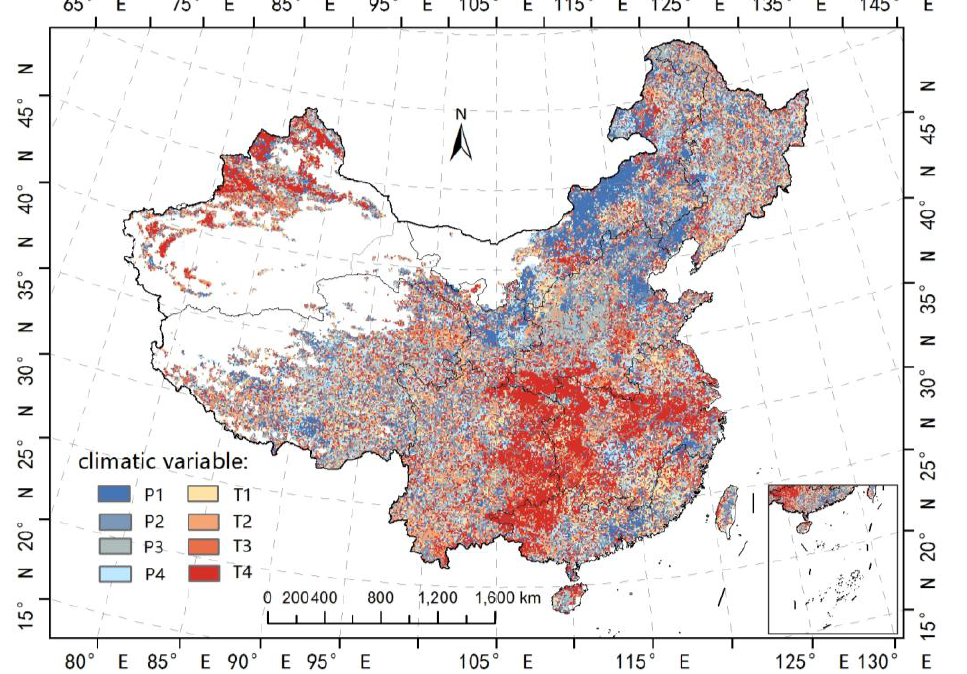
Figure 6. Spatial distribution of the main climatic variables affecting growing-season NDVI. P1, P2, P3, and P4 indicate the total precipitation during the current growing season, previous growing season, Stage 2, and Stage 1, respectively, and T1, T2, T3, and T4 indicate the mean temperature during these same periods,